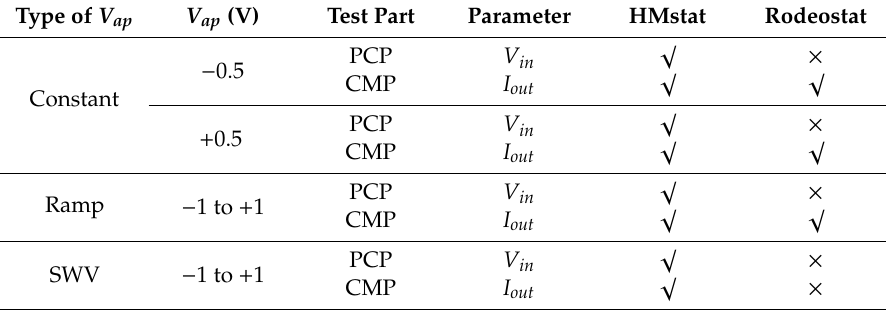
Table 1. Type of potential applied to the HMstat and